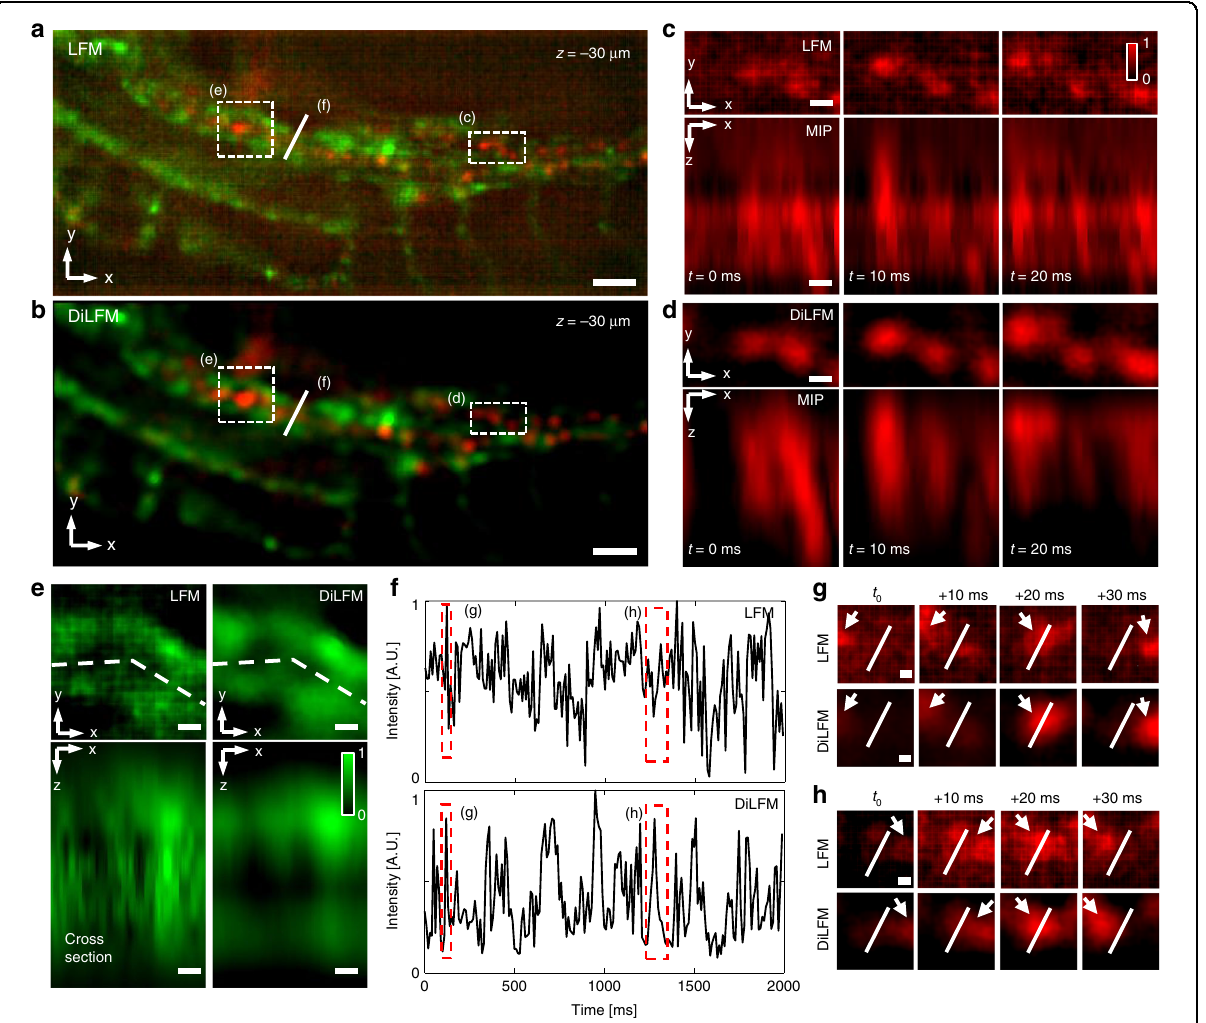
Fig. 4 High-speed Zebra fi sh blood fl ow imaging in 3D under extremely low illumination power. a , b Reconstructed zebra fi sh blood cell volumes by LFM and the DiLFM at z = − 30 µm under 0.15 mW mm − 2 (488 nm) and 0.12 mW mm − 2 (561nm) illumination, respectively. The red color shows the blood cells and the green color shows blood vessel walls. c Zoom-in area marked by the white dashed box in ( a ) and corresponding maximum intensity projection (MIP) along the y -axis by RL at different time stamps. d Zoom-in area marked by the white dashed box in ( b ) and corresponding MIP along the y -axis by DiLFM at different time stamps. e Zoom-in area marked by the white dashed box in ( a ) by LFM (left column) and in ( b ) by DiLFM (right column). f Time-lapse reconstructed intensity along the white line in ( a ) by LFM (top) and by DiLFM (bottom) at z = − 30 µm. g , h Zoom-in area around the white line in ( a ) and ( b ) in 30 ms time window by LFM (top) and DiLFM (bottom). The time window is indicated by the dashed box in ( f ). Arrows mark the blood cell at z = − 30 µm at different time stamps. The white lines in ( g ) and ( h ) are the same as the lines in ( a ) and ( b ). Scale bars in ( a ) and ( b ) are 50 µm, in ( c – e ) are 10 µm, in ( g ) and ( h ) are 5